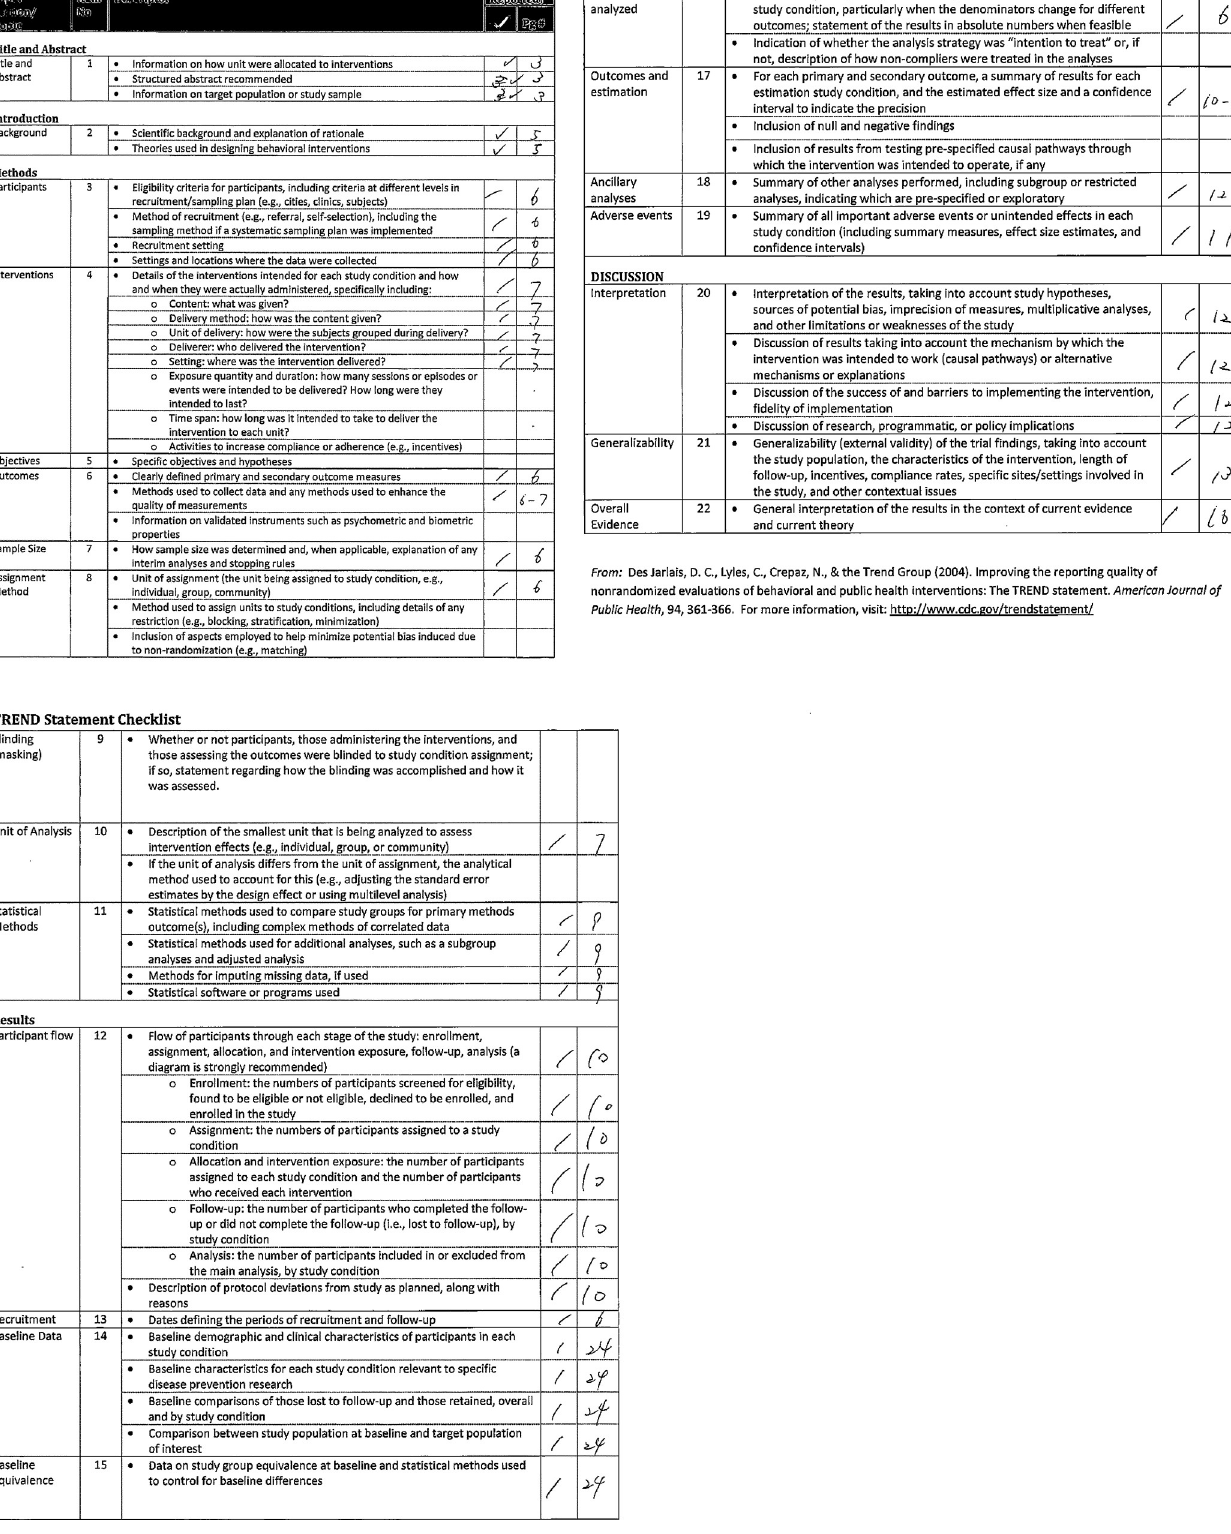
Fig 2. TREND checklist. We checked 22 points including TREND statement checklist. All points were included in our study.